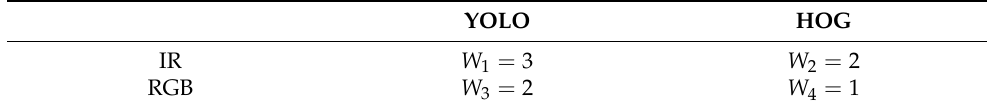
Table 1. Weights assigned to every configuration.